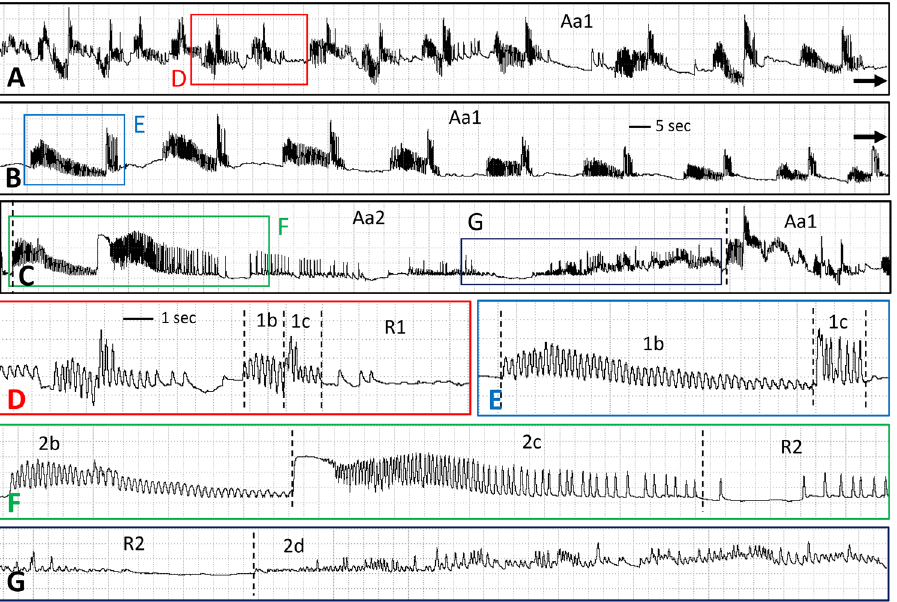
Figure 2. EPG waveforms for A. americanum feeding approx. 36 h after attachment to calf. ( A–C) Compressed view of one event of Aa1, showing appearances of successive episodes during the progression of the event through three rows of waveforms. Labelled boxes contain waveform segments that are expanded in parts with the same letter label. Scale bar in part (B) same for parts (A,C) . Windaq gain 64×. ( D) Two episodes of Aa1 showing four out of four types, Aa1b, Aa1c and AaR1, but with Aa removed from each label to save space. ( E) A later episode of Aa1 showing lengthened Aa1b. ( F) First third of one event of Aa2, showing three out of five types, Aa2b, Aa2c, and the first part of AaR2. ( G) Last third of one event of Aa2, showing last part of AaR2 and all of Aa2d. See narrative for further descriptions of waveform names. Scale bar in part D and Windaq gain of 128 × same for parts (D–G)